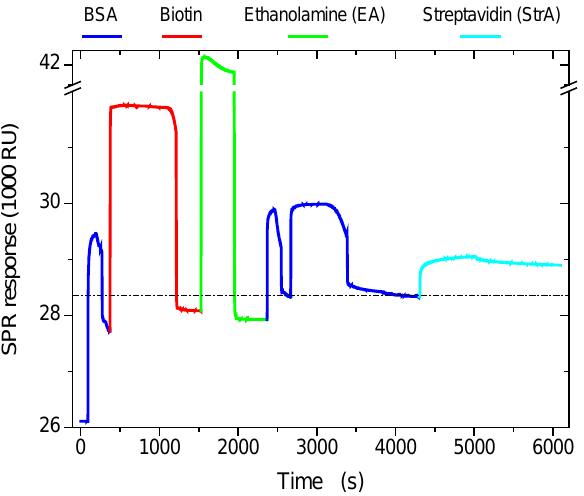
Figure 2. Surface plasmon resonance (SPR) response to a sequence of biomolecules adsorbed onto a polyelectrolyte-modified gold